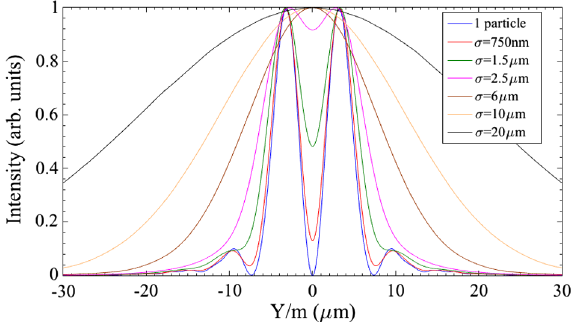
FIG. 7. Expected vertical beam profile obtained from the con- volution of the ATF2 OTR PSF with a Gaussian beam distribution. Simulations are performed for λ ¼ 550 nm and γ ¼ 2500 .